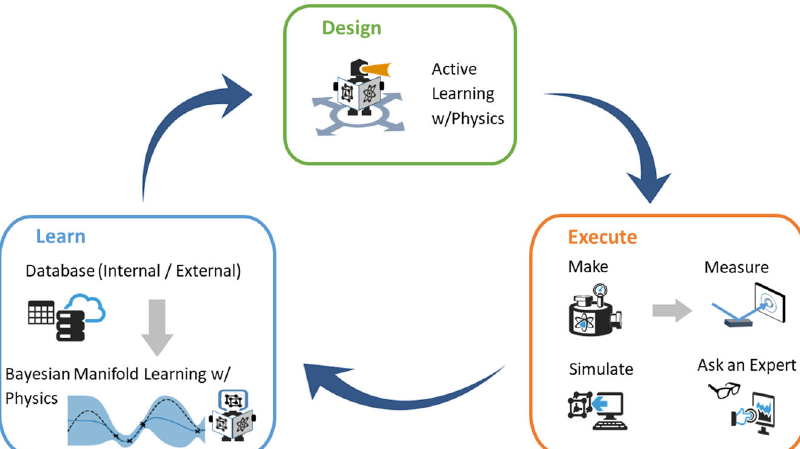
Fig. 5 Schematic for the autonomous experimental systems of the future. The AI in charge of the autonomous lab will have full control over the synthesis, characterization, and modeling tools. It will extract prior knowledge from structured databases, publications, and human guidance, do experiments and computations and be able to distill its fi ndings in a succinct mathematical form. Such autonomous laboratories are already being implemented in other areas of materials science 142 . (Icons used in the fi gure are from